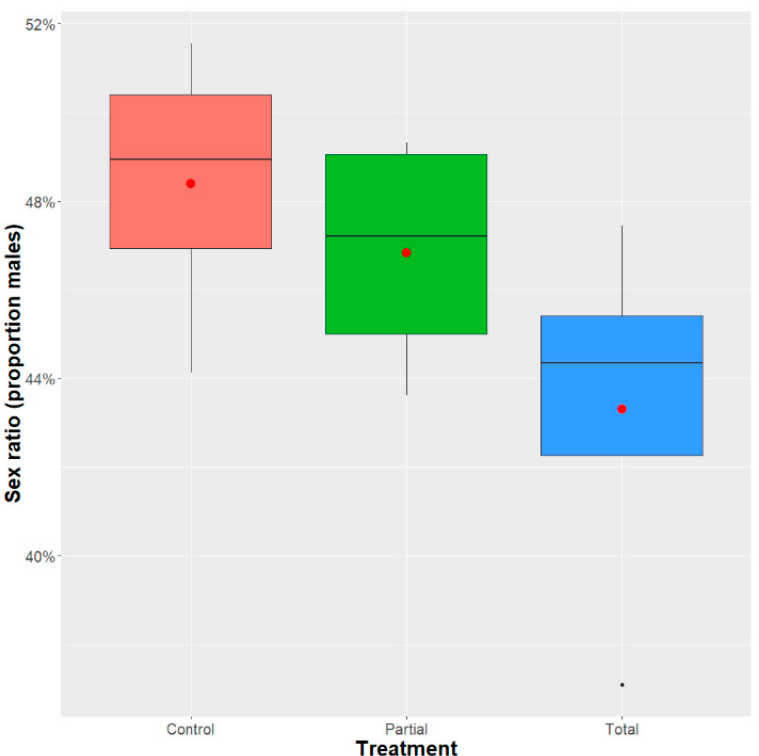
Figure 3. Sex ratio of males developed in the partial and total replacement of Enterobacter sp. AA26 diet and control diet. Sex ratio was determined as the percentage of males per total number of adults. A GLM (binomial family) analysis was performed to determine the effect of Enterobacter sp. AA26 diet replacement. Boxplots span the interquartile range and whiskers indicate the highest and lowest observations. The line and the dot inside each box represent the median and the mean, respec- tively. Significant differences between treatment groups are indicated with asterisks (*** p ≤ 0.001,